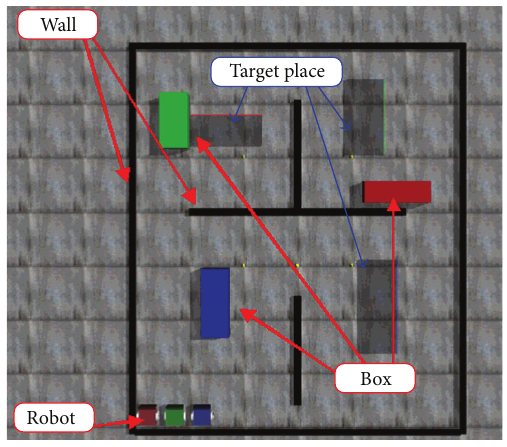
Figure 2: Overview of virtual work space for cooperative-carrying